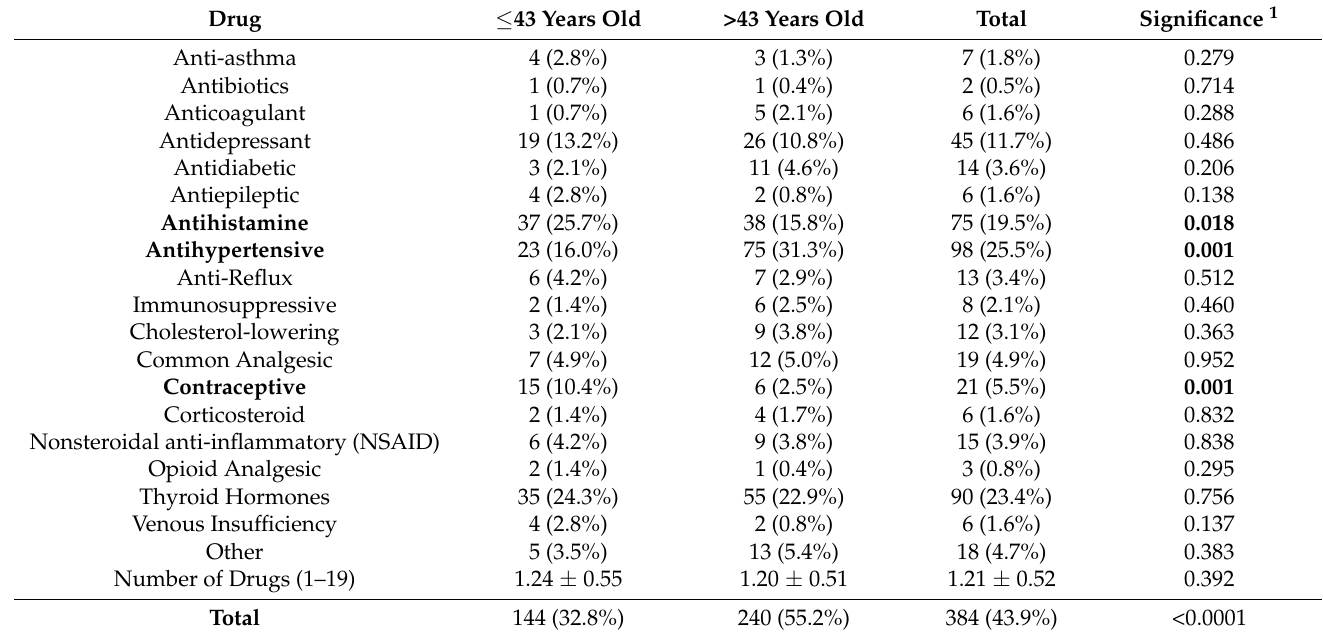
Table 4. Regularly taken drugs by the vaccinated healthcare workers in the Czech Republic, January–February 2021. Drug